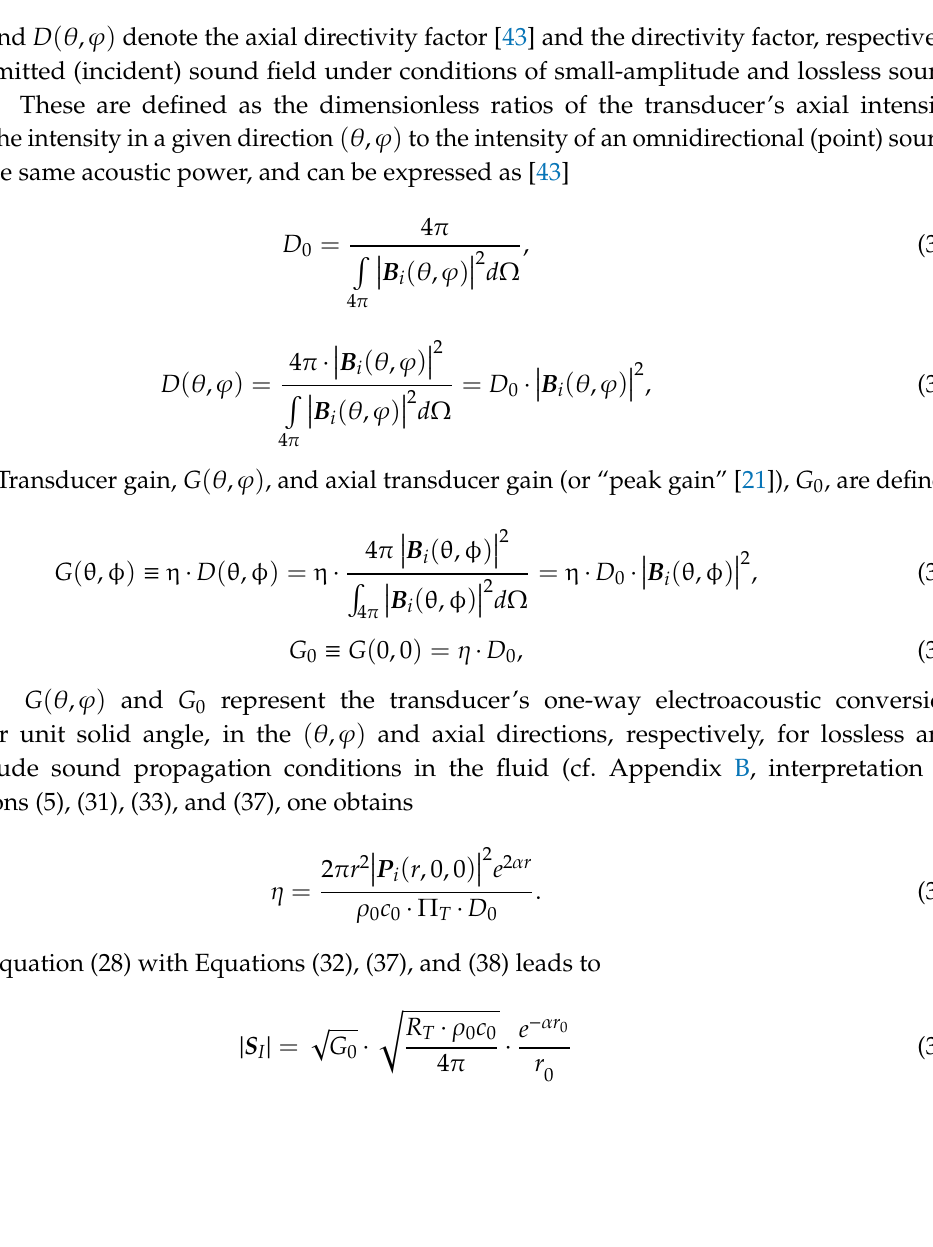
Figure 3. Sketch of the electrical connections for the electroacoustic transducer and electrical termination operating in ( a ) transmit and ( b ) receive modes. (Reproduced from [22], with permission from the Institute of Marine Research,